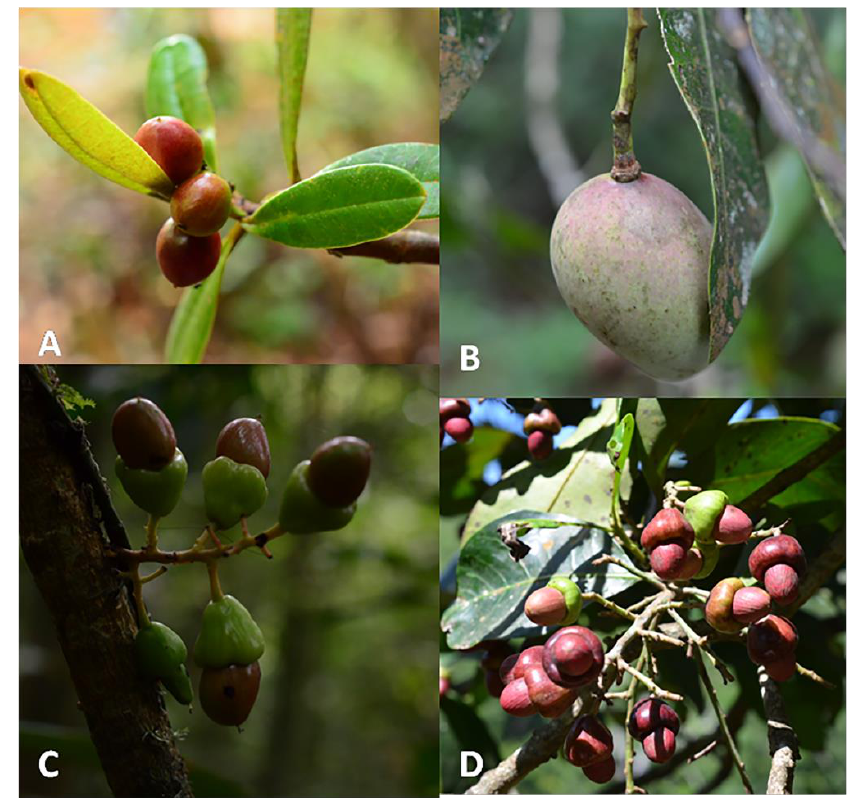
Figure 2: Fruits of ( A ). Campnosperma zeylanicum Thw. ( B ). Mangifera zeylanica (Blume) Hook.f. ( C ). Semecarpus marginata Thw. ( D ). Semecarpus nigro-viridis Thw.